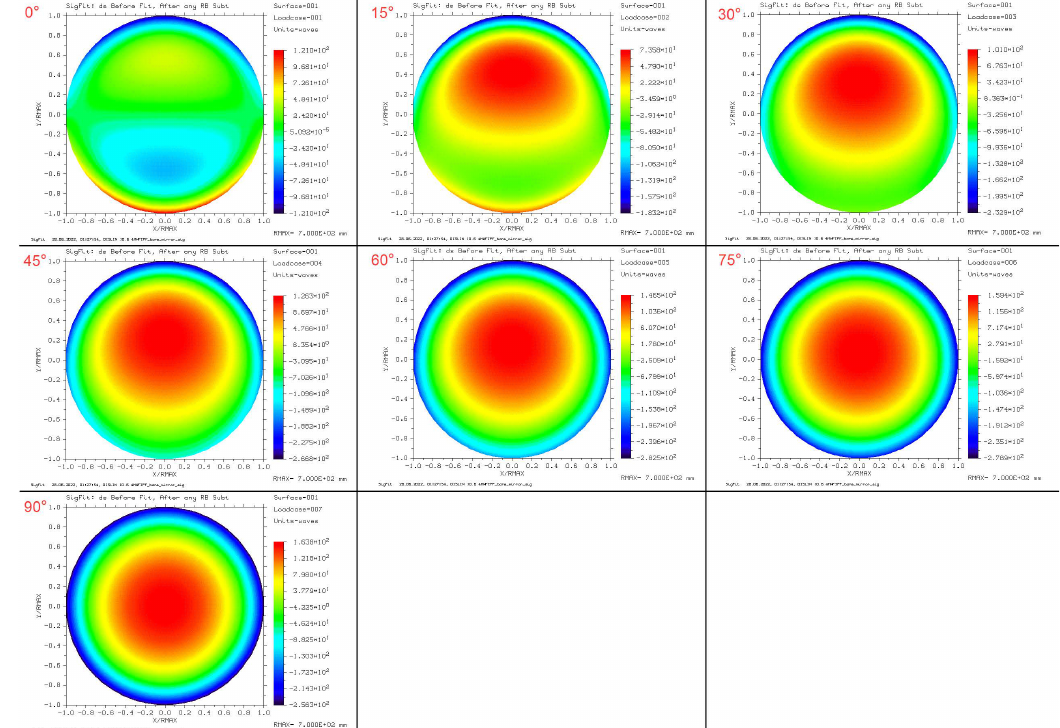
Figure 10. Normalized surface after removing rigid body displacement of L1S1.